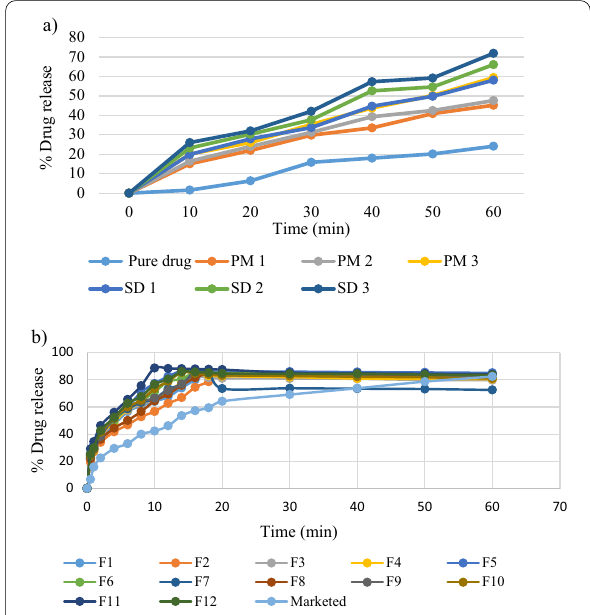
Fig. 2 a Dissolution studies of PM and SD. The graph represents a comparative dissolution profile between pure drug, PM and SD. b Dissolution studies of marketed and formulated orodispersible tablets. The graph represents a comparative dissolution